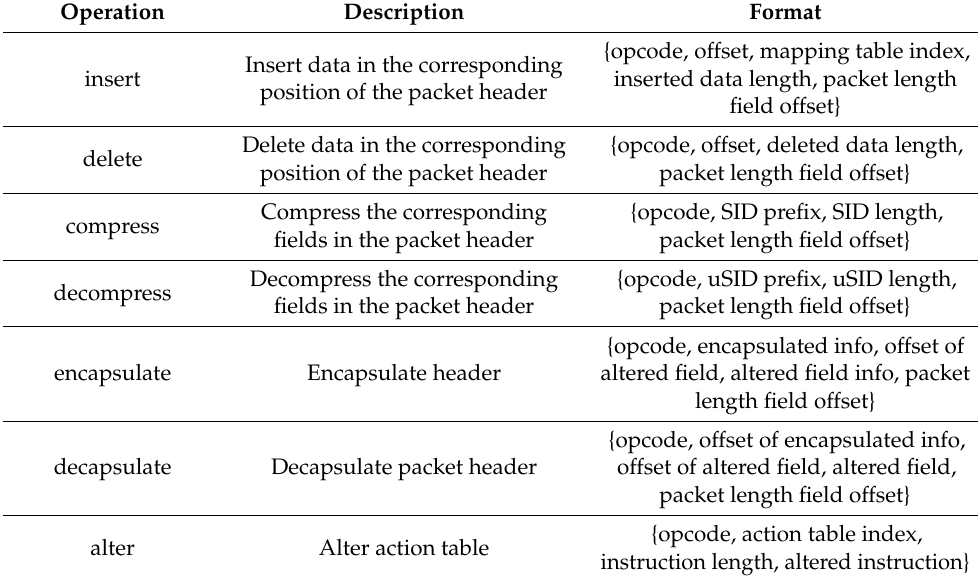
Table 2. Deparser plus instruction